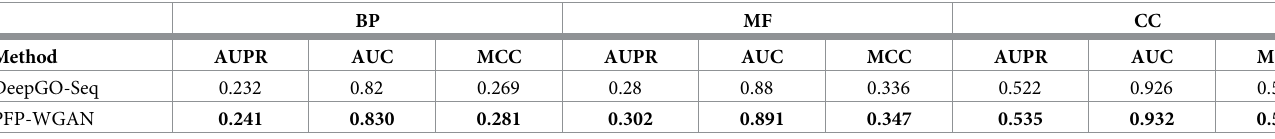
Table 1. Three term-centric measures suitable for unbalanced data. BP MF CC Method AUPR AUC MCC AUPR AUC